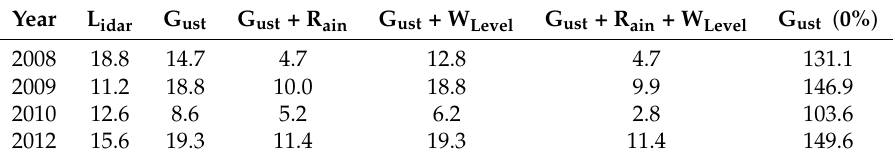
respective volume. Volumes in m 3